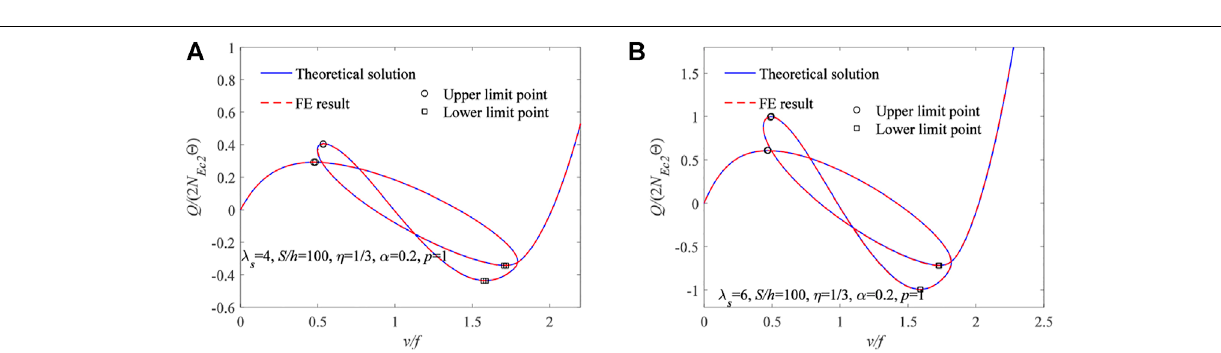
FIGURE 14 | ANSYS result and theoretical result of multiple limit point instability for pin-ended FGM arches having different types of cross-section: (A) Type 1. (B) Type 2.